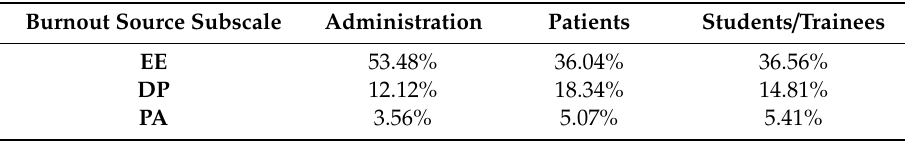
Table 3. Extracted Sum Squared Loading for the Modified MBI scale.